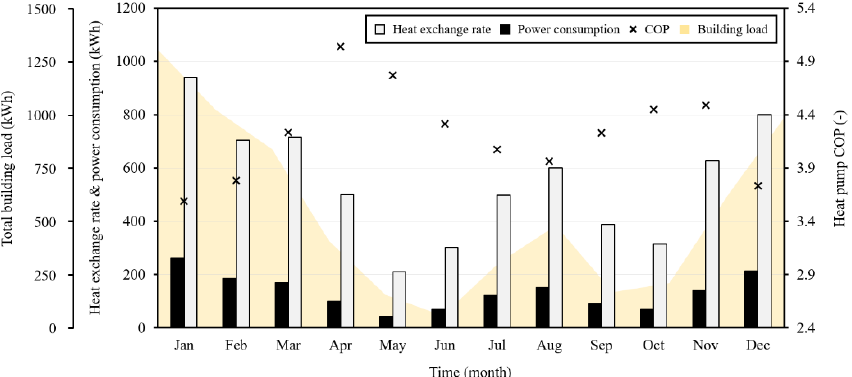
Figure 10. Monthly COP of the heat pump.